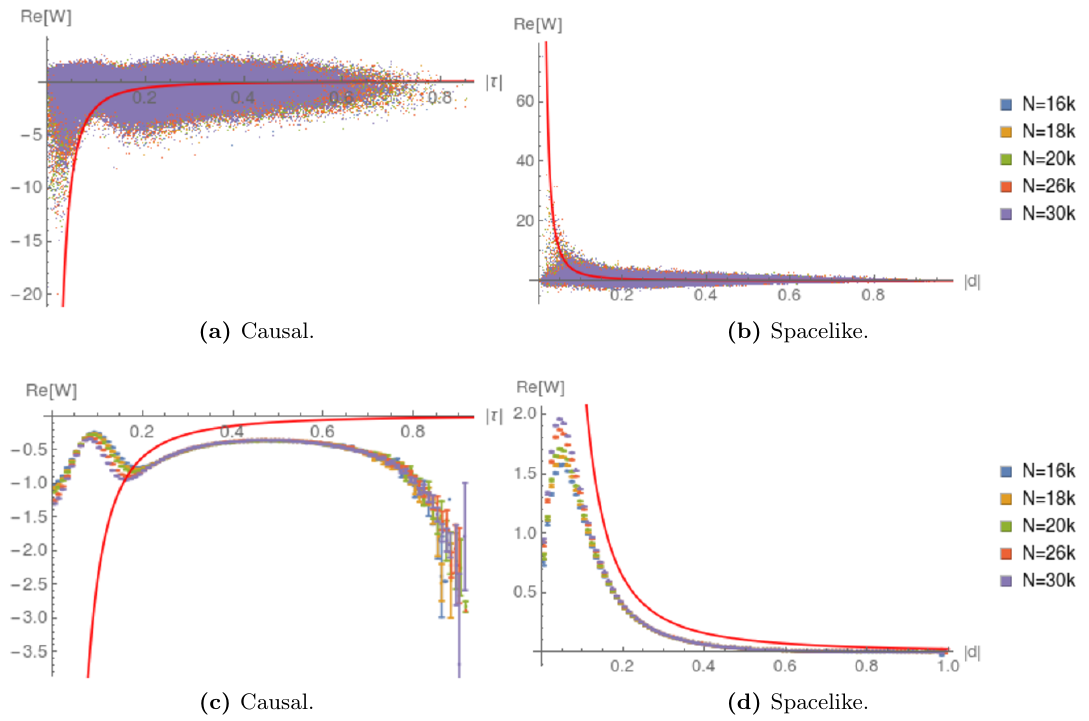
Figure 7. (a)-(b) represent Re[ W ] vs. geodesic distance for a sample of 100000 randomly selected SJ pairs, in the 4d causal diamond; m = 0. (c)-(d) are plots of the binned and averaged data with